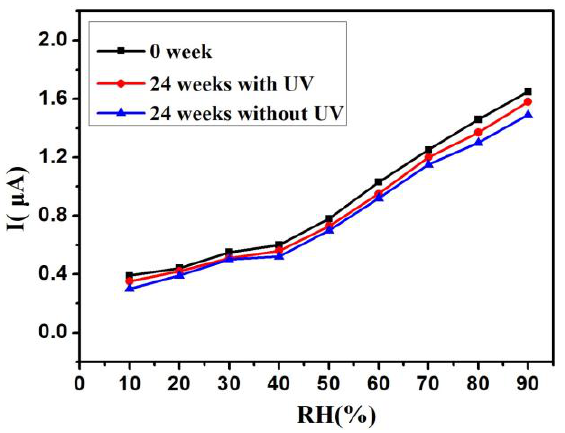
Figure 12. The humidity sensor stability after the sensors were exposed to air for 24 weeks with UV and without UV.